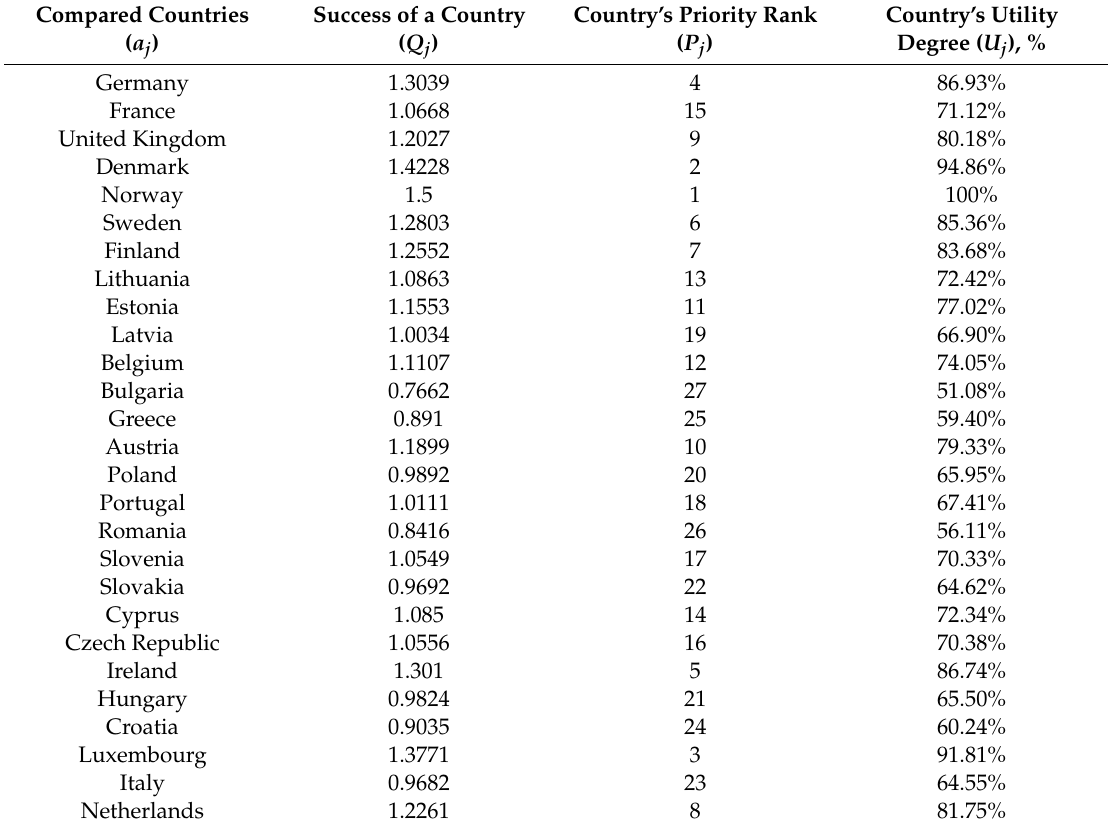
Table 2. Outcomes of the multiple criteria evaluation of the construction industries of 25 EU countries, the UK and